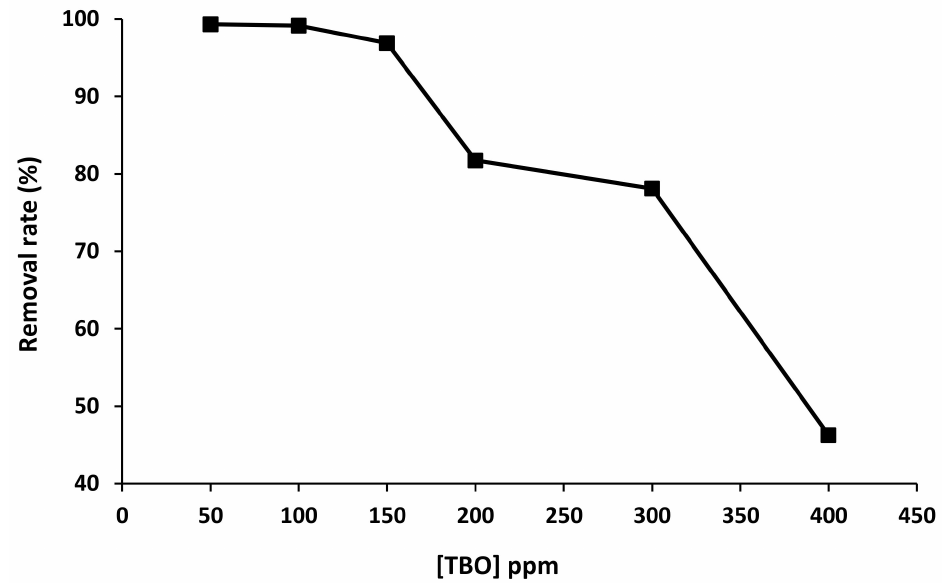
Figure 9. Effect of the initial TBO concentration on a Fenton-like reaction using AC-Fe. (pH = 3.5, [H 2 O 2 ] = 4 mmol/L, [AC-Fe] = 1.2 g/L, reaction temperature = 20 ◦